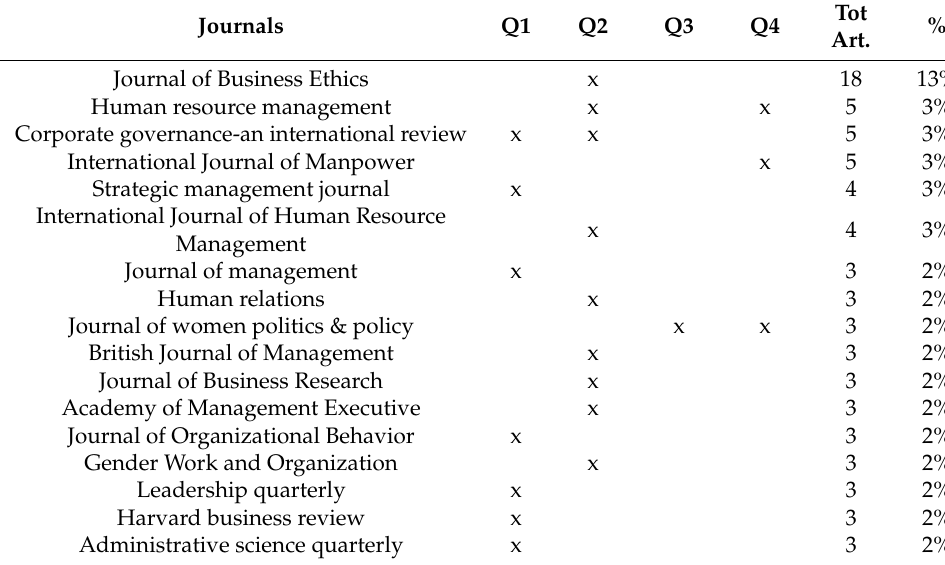
Table 4. JCR Listed Journals by